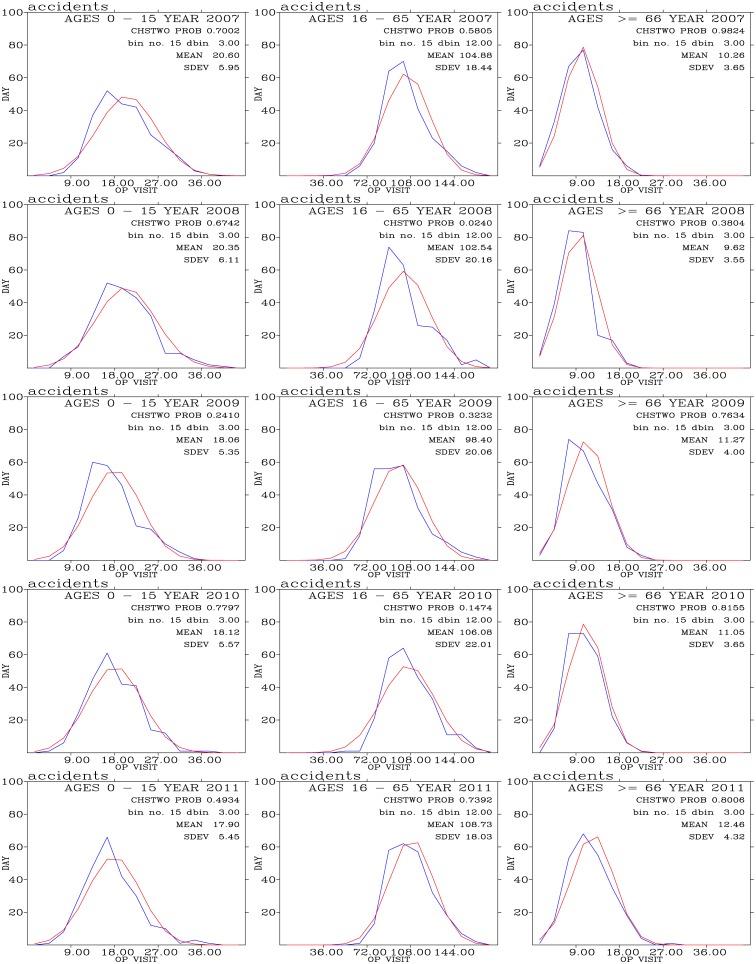
Normality test for the accident outpatient data.The frequency distribution of the daily number of outpatients is shown in blue, whereas the theoretical normal distribution is shown in red. The x-axis shows the ranges of the 15 bins (outpatients day−1). The y-axis shows the frequency of occurrence (days) for each of the 15 bins.